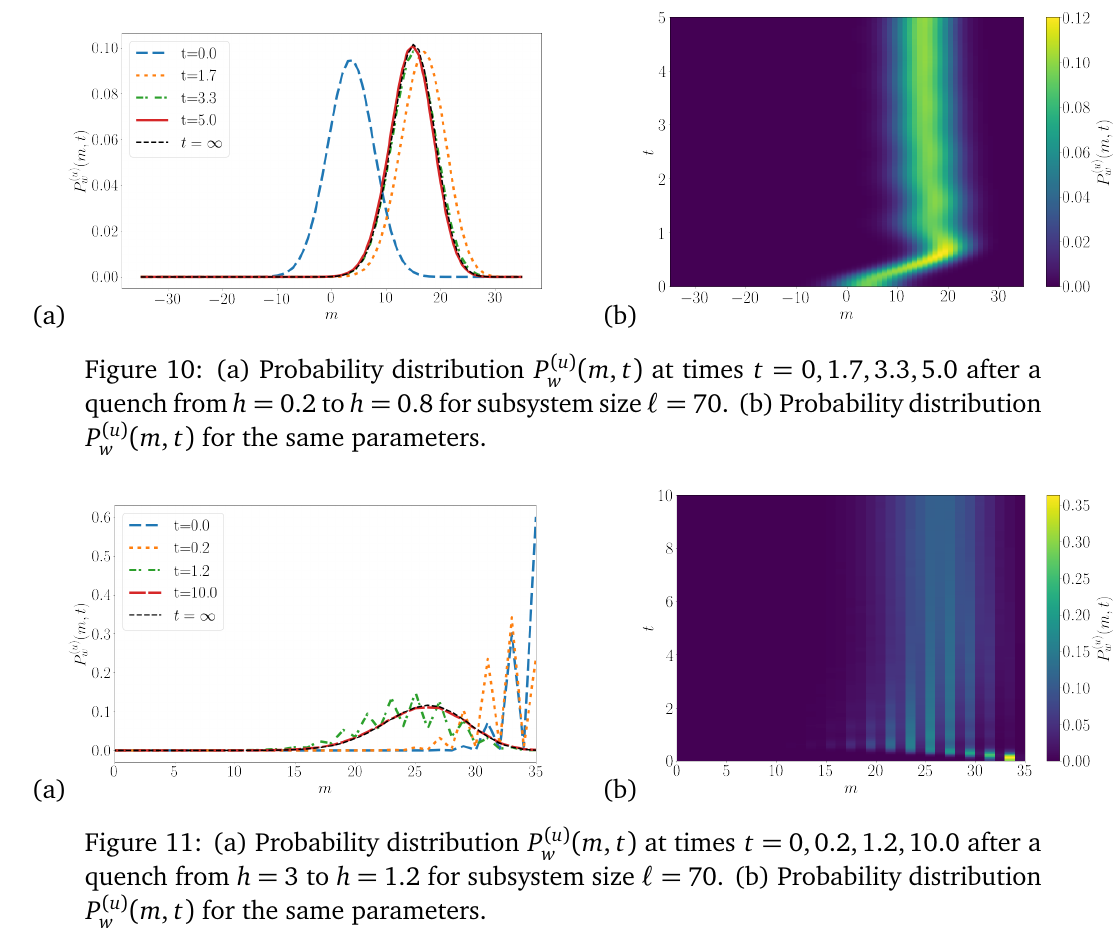
Figure 11: (a) Probability distribution P ( u ) quench from h = 3 to h = 1.2 for subsystem size (cid:96) = 70. (b) Probability distribution ( m , t ) for the same parameters. P ( u ) w